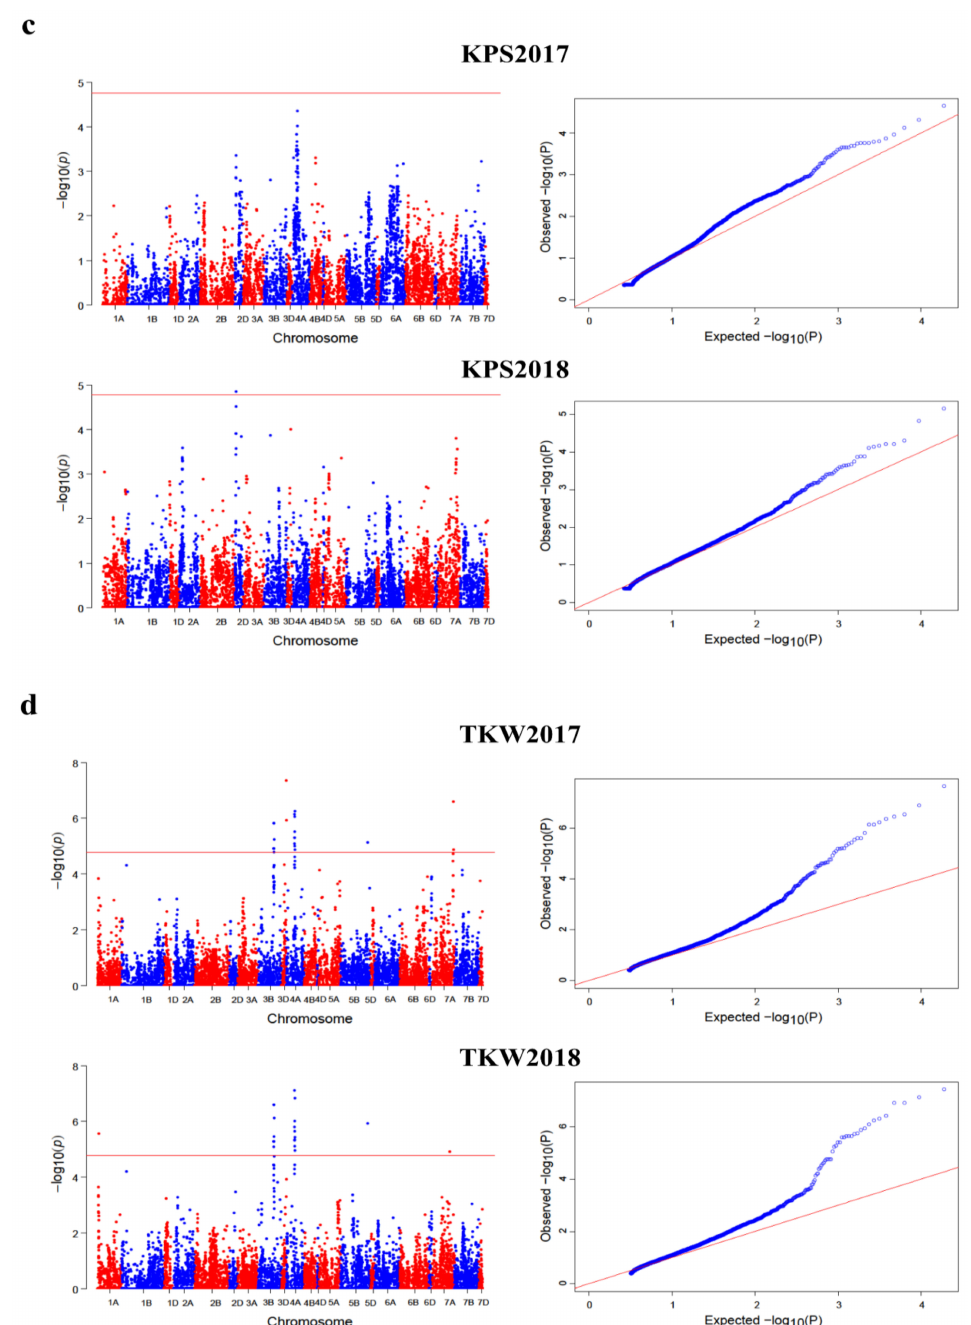
Figure 5. Manhattan and quantile–quantile (Q–Q) plots for the kernel traits across two environments (2017–2018): ( a ) Manhattan and Q–Q plots for kernel length; ( b ) Manhattan and Q–Q plots for kernel width; ( c ) Manhattan and Q–Q plots for kernels per spike; and ( d ) Manhattan and Q–Q plots for thousand kernel weight. Note: Number of detected SNPs by four multi-locus GWAS methods. For brevity, we present here the Manhattan and Q–Q plots of mrMLM model. The rest of the Manhattan and Q–Q plots are given in Supplementary Figure